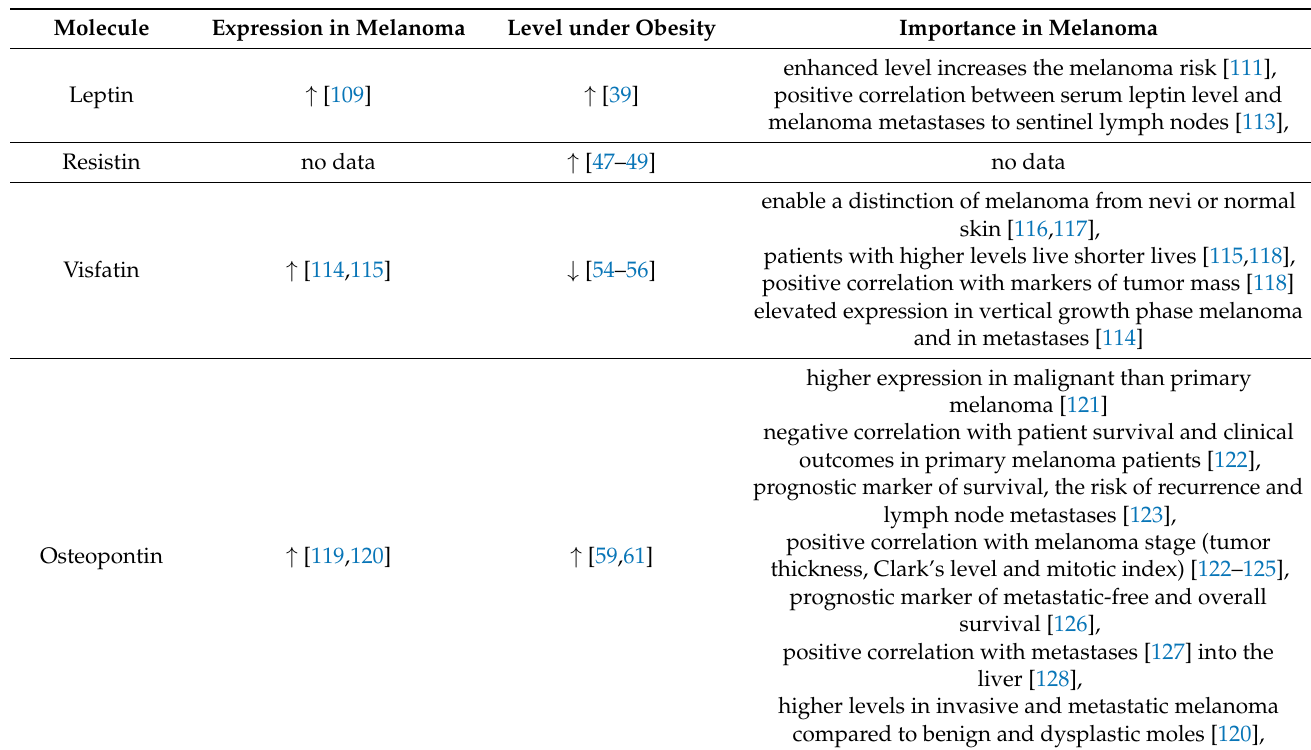
Table 2. Comparison of the adipokines expression in melanoma. Abbreviations: + detected expression, ↑ overexpression, ↓ decreased